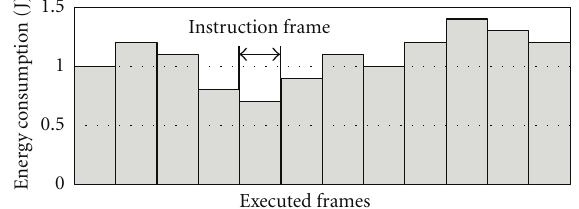
Figure 3: An example of instruction frame.